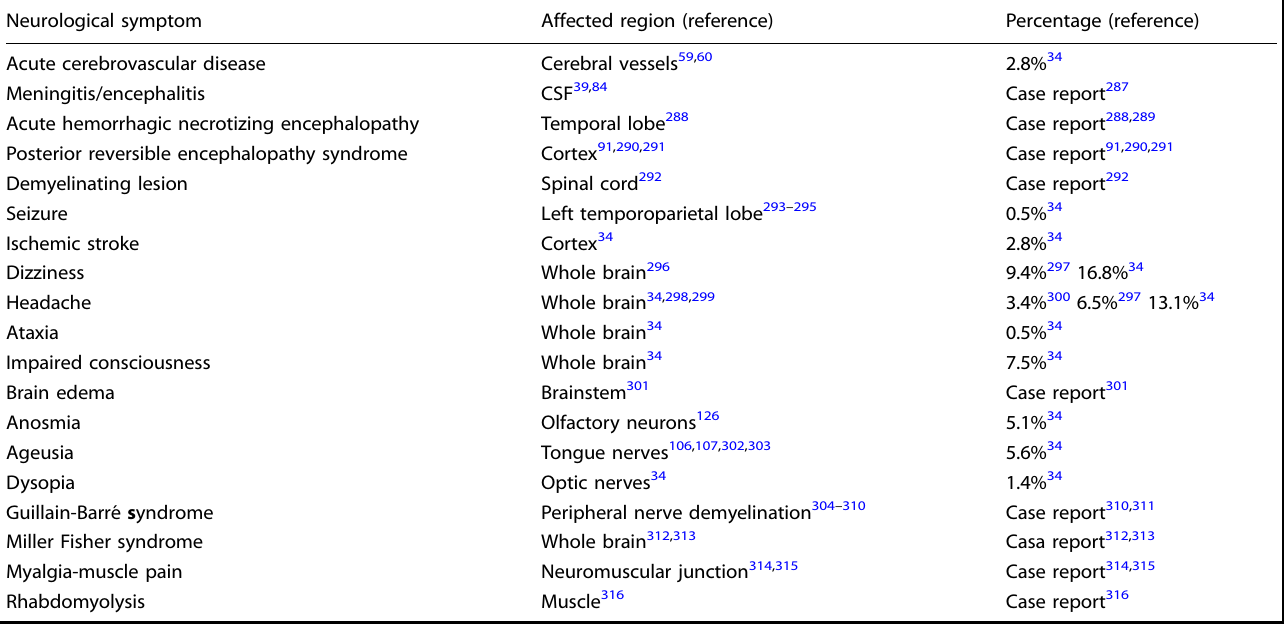
Table 1. Neurological symptoms in COVID-19